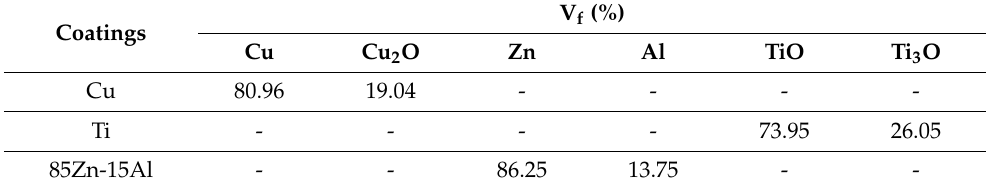
Figure 4. XRD of the coatings. Table 2. V f (%) of the